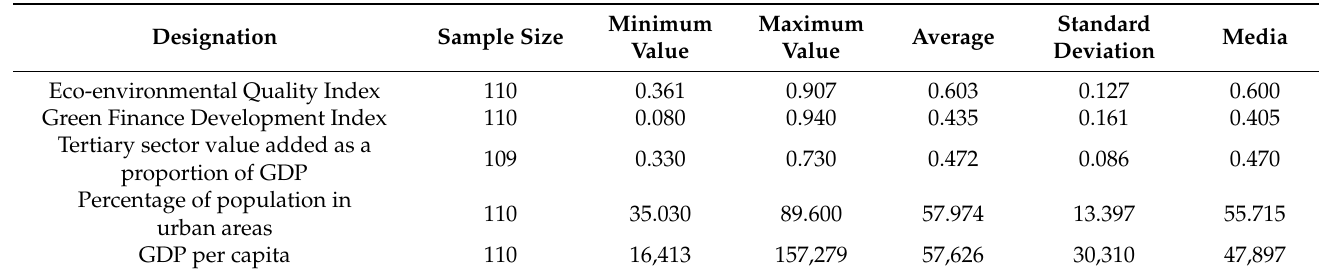
Table 7. Basic indicators.